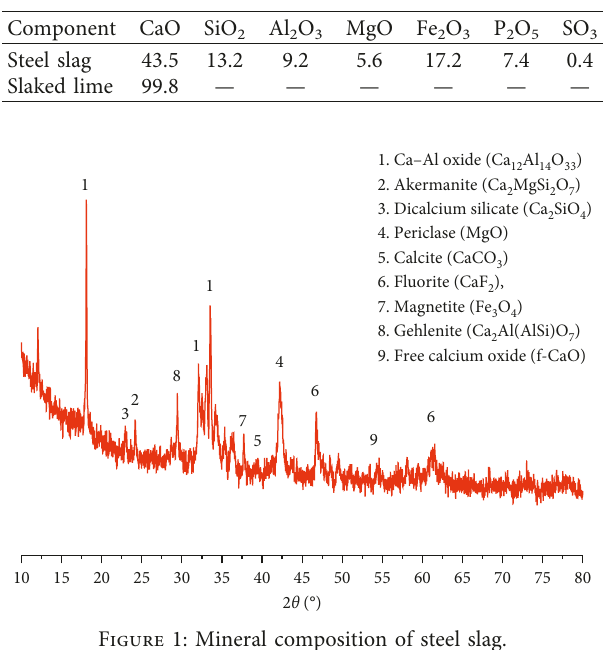
Table 1: Chemical compositions (wt.%).